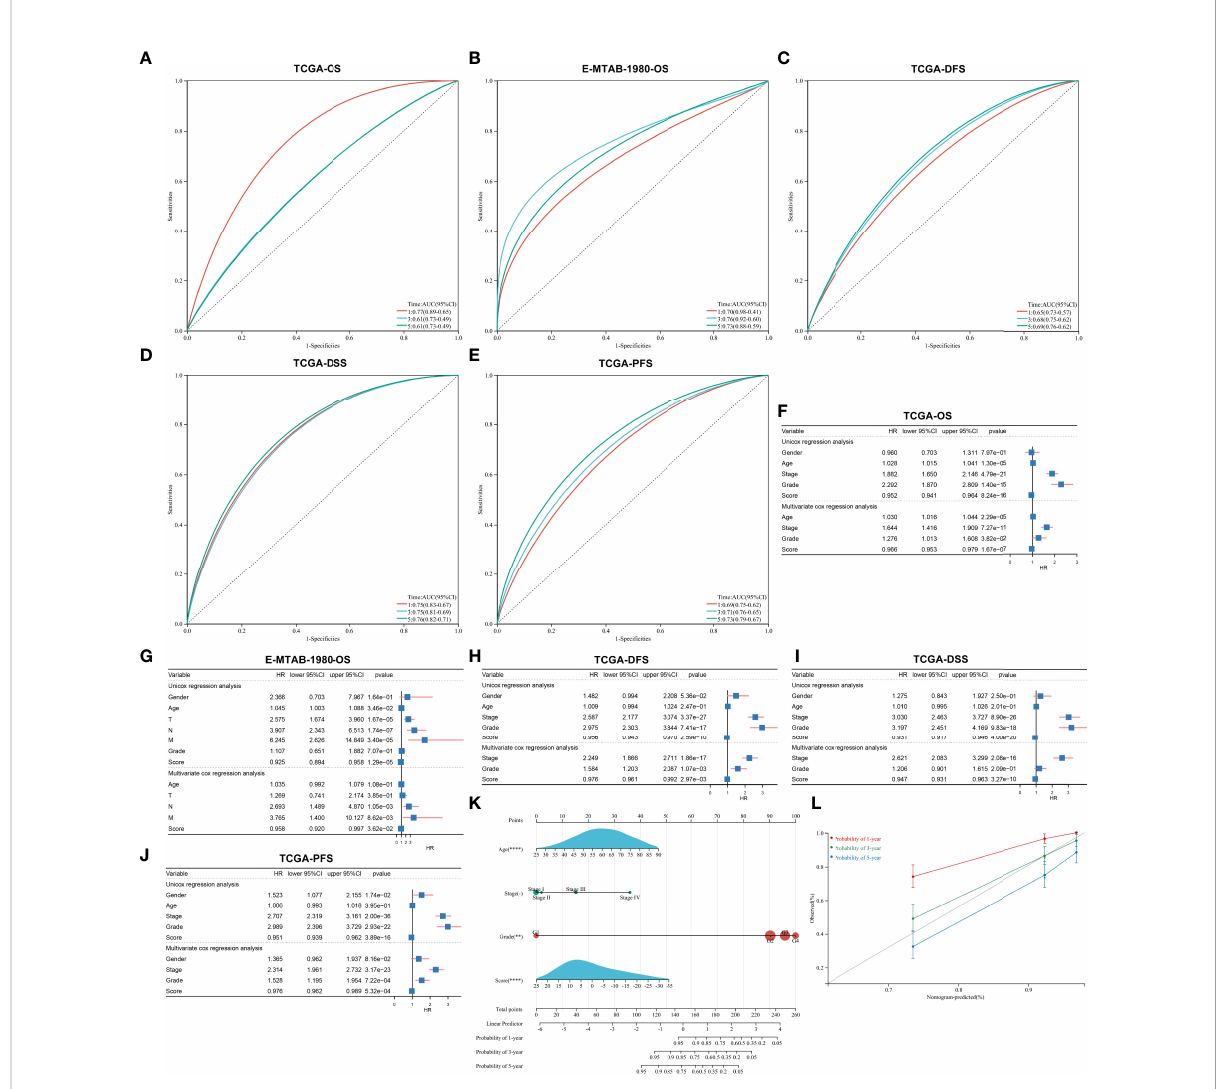
FIGURE 7 Validation of the predictive performance of the agingScore and generation of an agingScore-based nomogram for ccRCC prognosis. (A, B) ROC diagram of the 1-, 3-, and 6-year OS in the TCGA-KIRC cohort and the E-MTAB-1980 cohort. (C – E) ROC curves of the 1-, 3-, and 5-year DFS, DSS, and PFS in the TCGA-KIRC cohort. (F, G) Univariate and multivariate Cox regression models of agingScore as well as clinical features with OS in the TCGA-KIRC and E-MTAB-1980 cohorts. (H – J) Univariate and multivariate Cox regression analyses of agingScore and clinical features with DFS, DSS, and PFS in the TCGA-KIRC cohort. (K) Generation of an agingScore-based nomogram comprised of independent predictive indicators in the TCGA- KIRC cohort. ( L ) Calibration diagram for the nomogram-estimated and actual 1-, 3-, and 5-year OS in the TCGA-KIRC